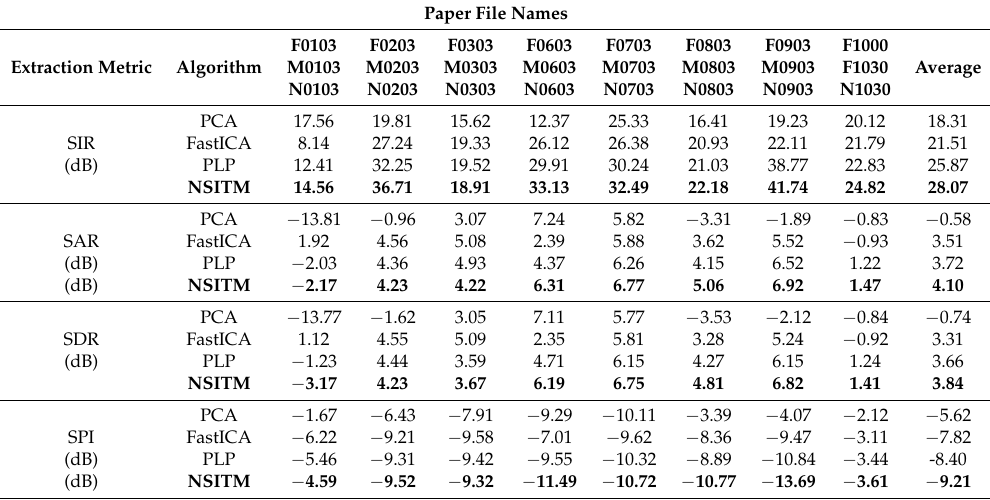
Table 3. Comparison between the FECG extraction performances (SPI, SIR, SAR, and SDR), using the proposed NSITM, PCA, and FastICA algorithms, considering SNR = 6 dB. Data are collected from Physionet/Fetal ECG Synthetic database